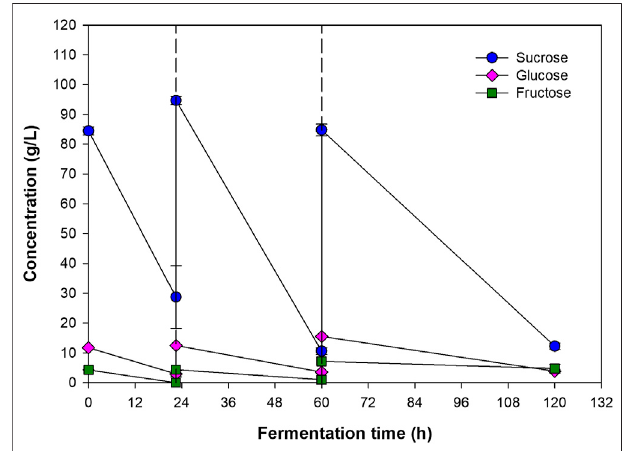
FIGURE 5 | Concentrations of sucrose, glucose, and fructose at the beginning, before and after fi rst and second feedings of the feed, and the end of the process. The dashed lines represent the time at which fresh medium was fed into the